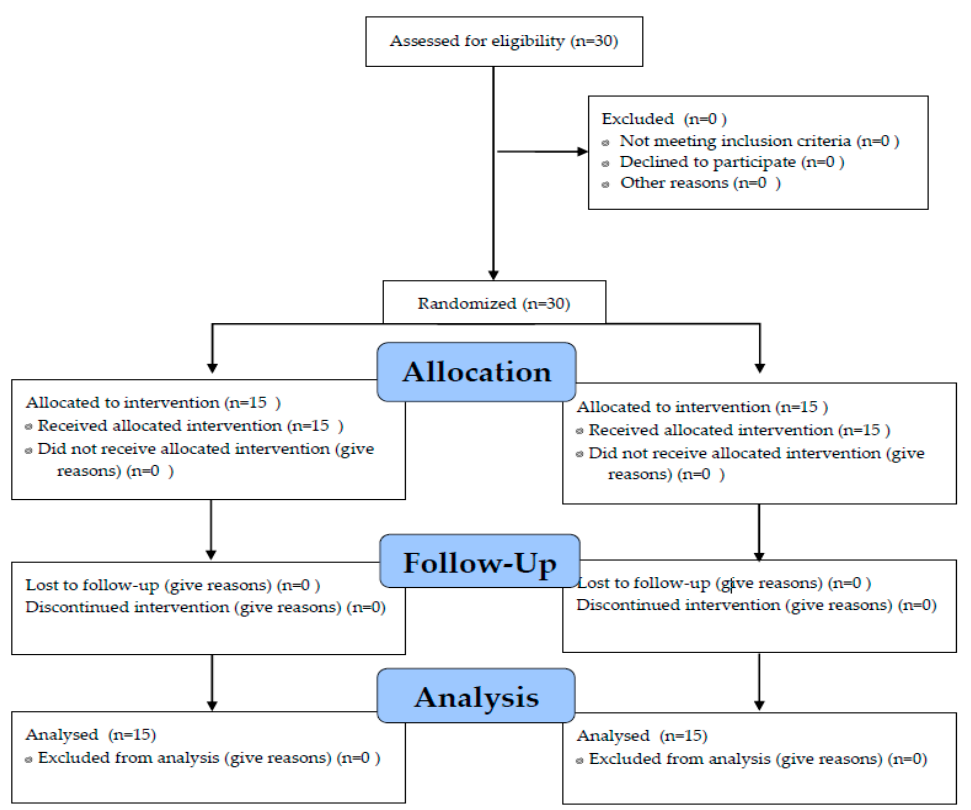
Figure 1. CONSORT Flow Diagram.